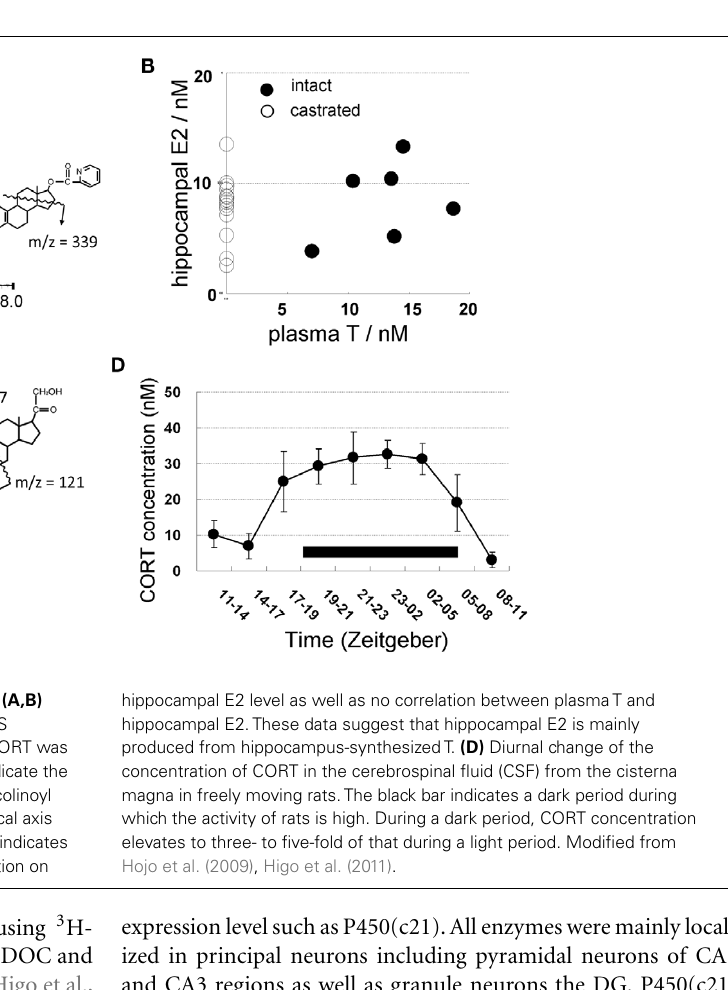
FIGURE 4 | Mass-spectrometric determination of sex steroids (A,B) and corticosteroids (C,D) in the male hippocampus. LC-MS/MS chromatograms and steroid derivatives of (A) E2 and (C) CORT. CORT was extracted from the hippocampus of ADX rats. Shaded portions indicate the intensity of the fragmented ions of 17 β -E2-pentafluorobenzoxy-picolinoyl [m/z = 339, (A) ] and CORT [m/z = 121, (C) ], respectively.The vertical axis indicates the intensity of the fragmented ions.The horizontal axis indicates the retention time of the fragmented ions. (B) No effect of castration on